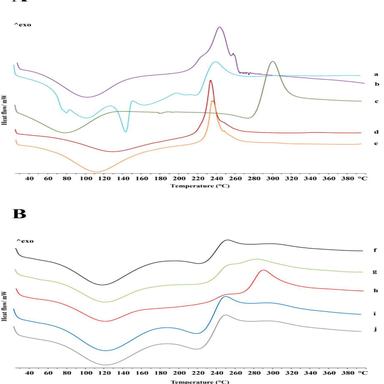
Differential scanning calorimetry thermograms of alginate, amidated pectin, chitosan, and sodium hyaluronate raw material in comparison to in situ gelling powders. Panel A: amidated pectin (a), alginate (b), chitosan (c), sodium hyaluronate high molecular weight (d), sodium hyaluronate low molecular weight (e). Panel B: APC 111 (f), APC 113 (g), APC 117 (h), APCH 111-2HH (i) and APCH 111-2LH (j)